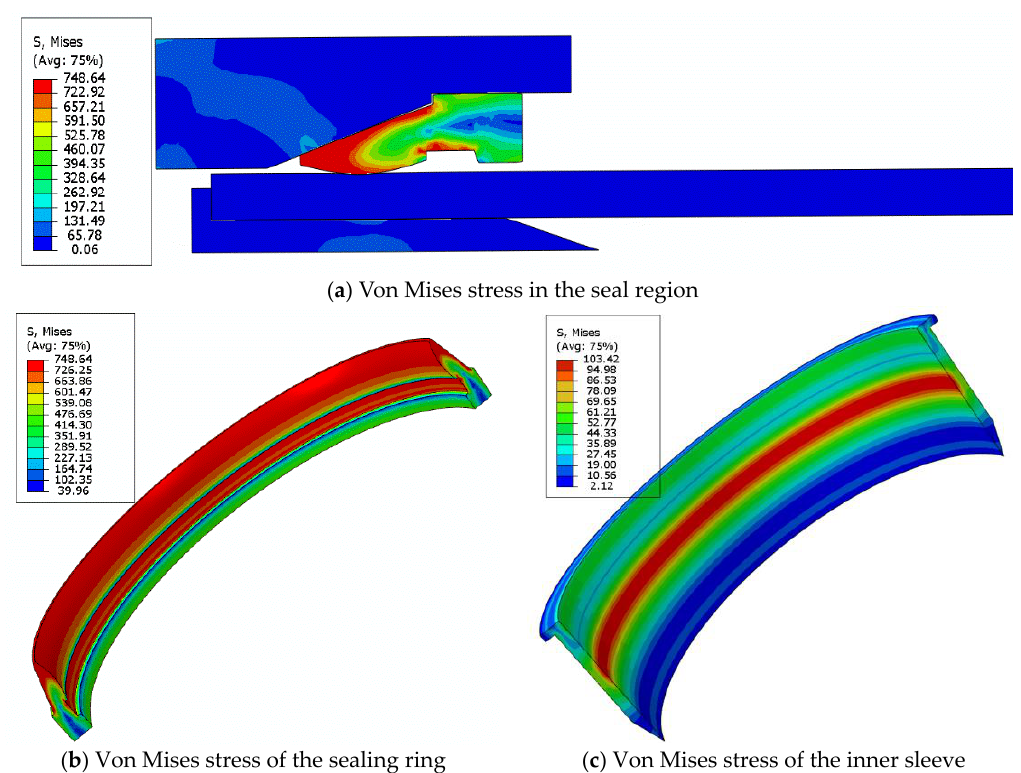
Figure 6. Von Mises stress distribution of the FE model.